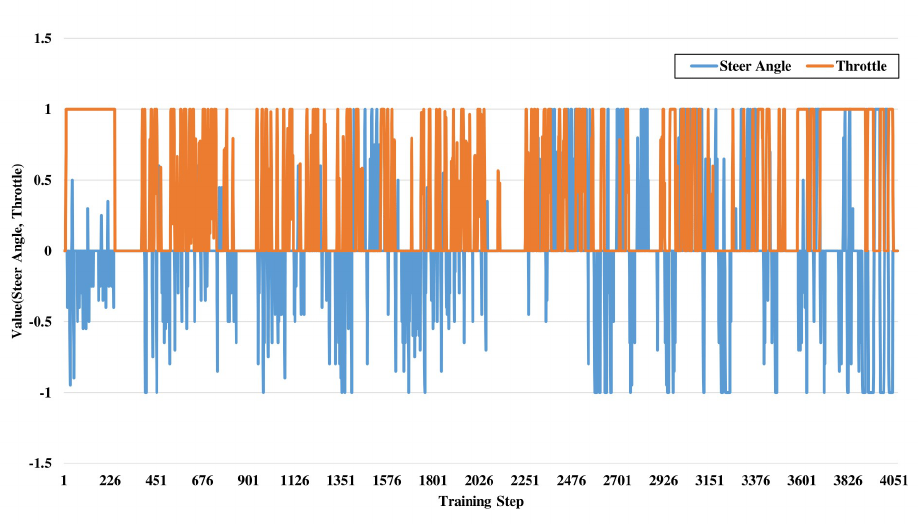
Figure 5. Training data model object classification: steering and throttle angle.